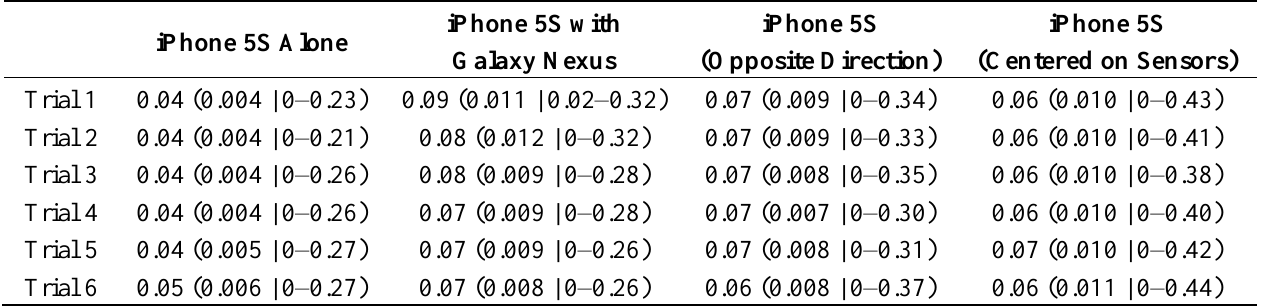
Table 1. Effect of position, Root Mean Square (RMS) (variance | min–max) for roll in degrees.